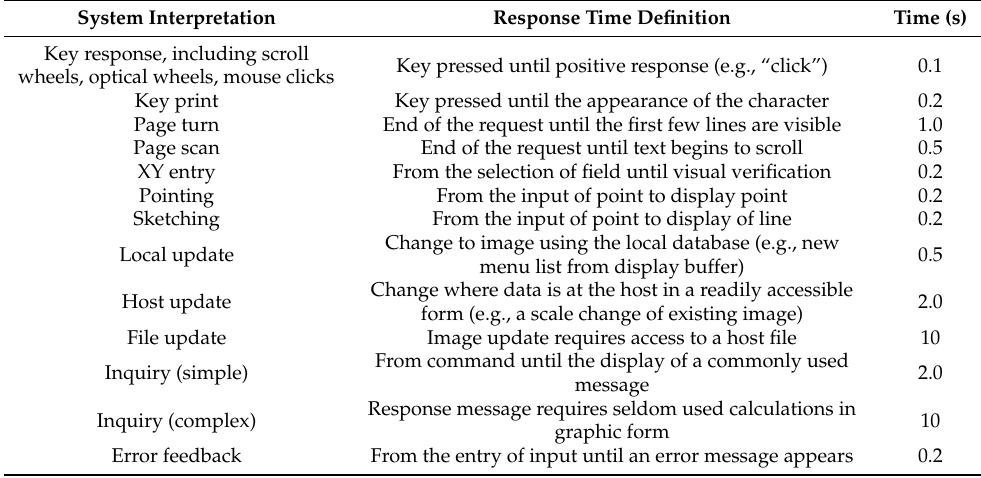
Table 3. Acceptable System Response Times.